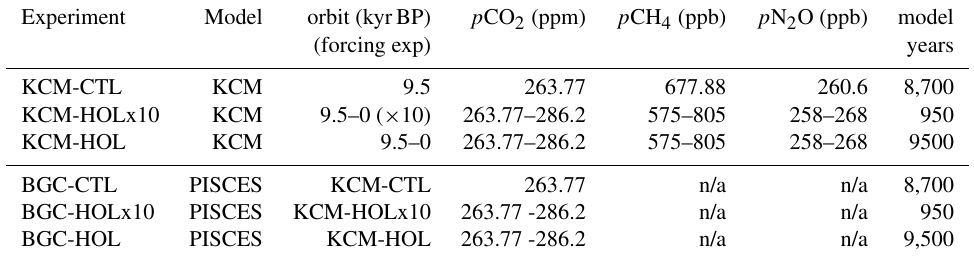
Table 1. Experiment names and characteristics. See also Fig. 1 for the temporal evolution of atmospheric greenhouse gases. Lower entries in column “forcing exp” indicate the KCM experiments that have been used to force the BGC experiments. ( × 10) indicates an acceleration factor of 10. CH 4 and N 2 O are not prescribed in PISCES.